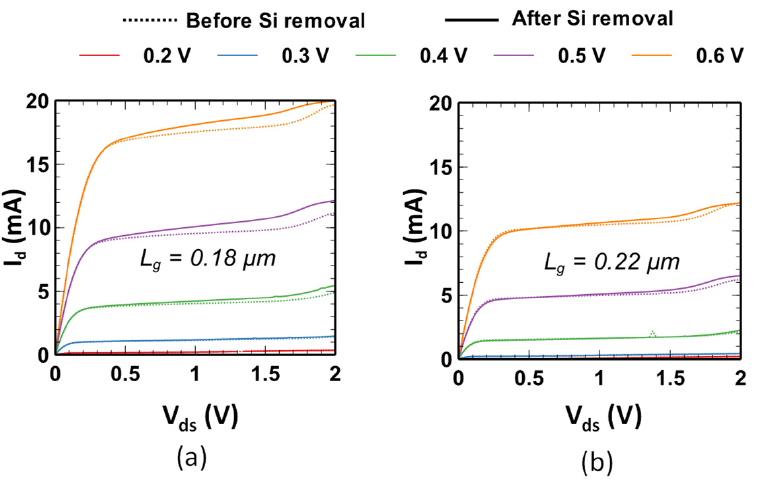
Figure 10. Static I ds − V ds characteristics of the ON branch of the SP9T switch structure on TR-SOI substrate before and after silicon removal based on unitary MOS transistors with two different gate lengths ( a ) 180 nm; ( b ) 220 nm.